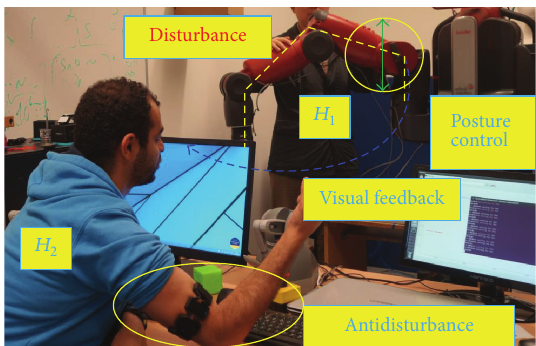
Figure10:RobotarmantidisturbancetestIforposturemaintenance (the dash yellow line) control: robot arm imitates human arm stiffnessadaptivefeaturesinperturbationenvironment.Humanarm will get cocontracted to compensate the external disturbance and this feature is transferred to robot arm by extraction of stiffness variations from sEMG signals.